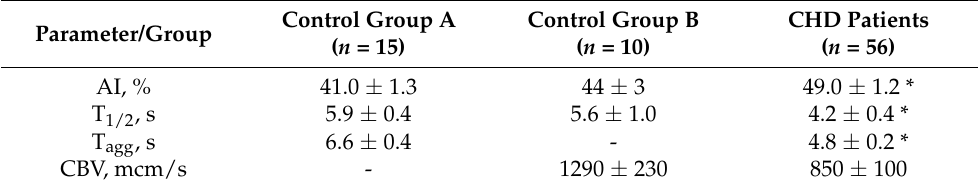
Table 2. The comparison of CHD patients and the control groups. The averaged values and the standard errors are presented. The p -value was calculated by a two-tailed t -test with unequal variance.